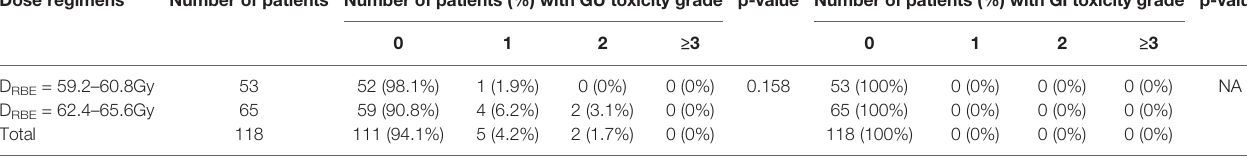
GU, genitourinary; GI, gastrointestinal, NA, not applicable.